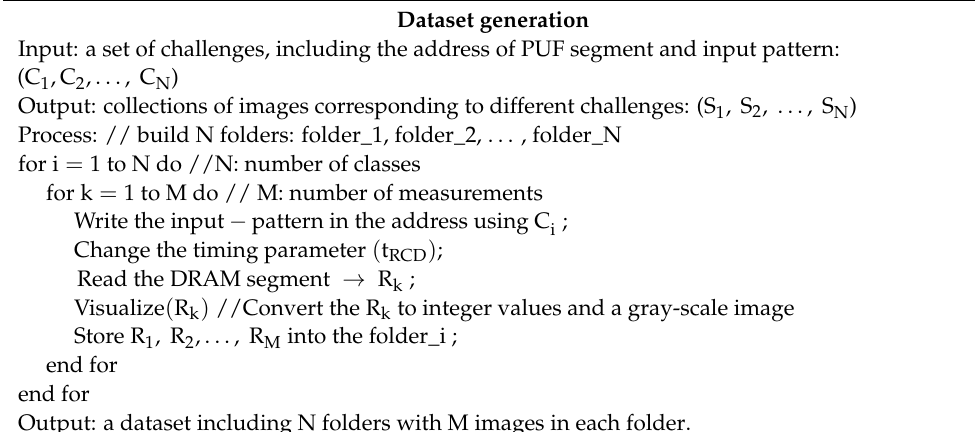
Algorithm 1 Convolutional neural network (CNN)-based classification Dataset